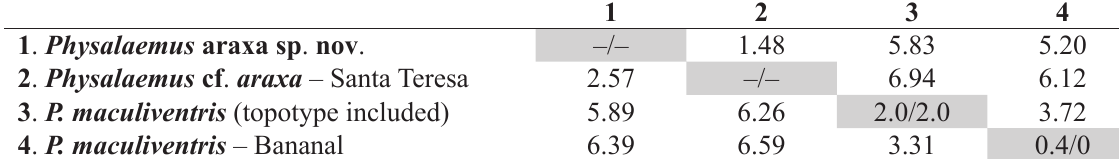
Table 6. Uncorrected p -distances (%) between Physalaemus araxa sp. nov., P. maculiventris , and Physalaemus cf . araxa from Santa Teresa, ES. In the lower triangle, values estimated from H1 fragments; in the upper triangle, values inferred from the 16Sar-16Sbr fragment of the 16S rRNA gene (540 bp). Diagonal line presents uncorrected p -distances identified within each species or lineage, based on the H1 (left) and 16Sar-16Sbr (right) fragments. En-dash denotes that only one sequence is